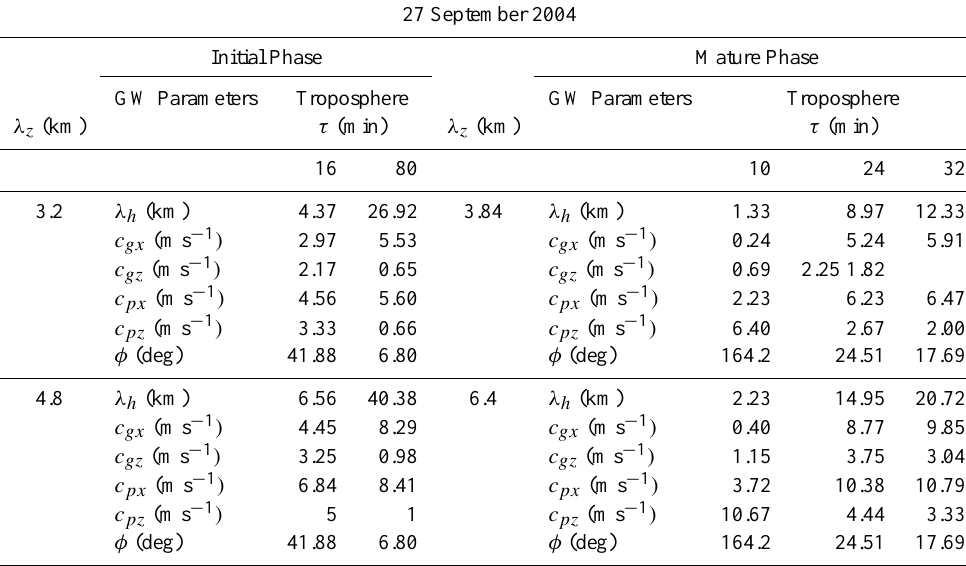
Table 2a. Gravity wave dispersion parameters for 27 September 2004 in the troposphere.